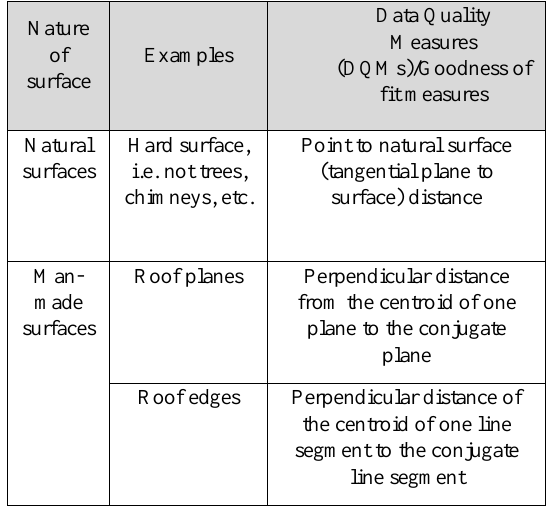
Table 1 Data Quality Measures (DQMs) or inter-swath goodness of fit measures